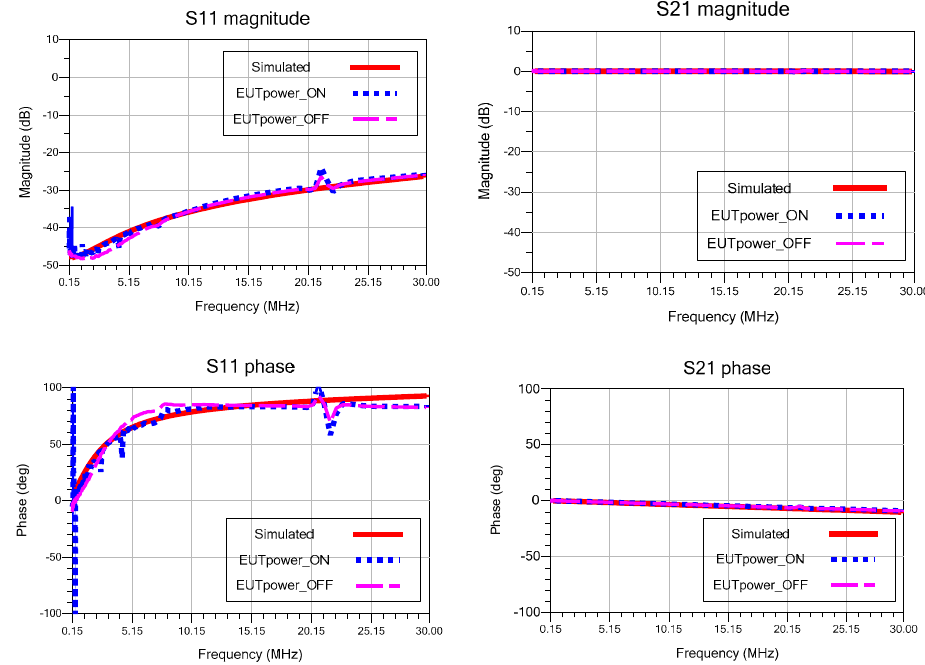
Figure 9. Comparison of the S-parameters obtained by simulations (red), EUT powered (blue), and EUT not powered (pink) for the Buck Converter Model LM2596.